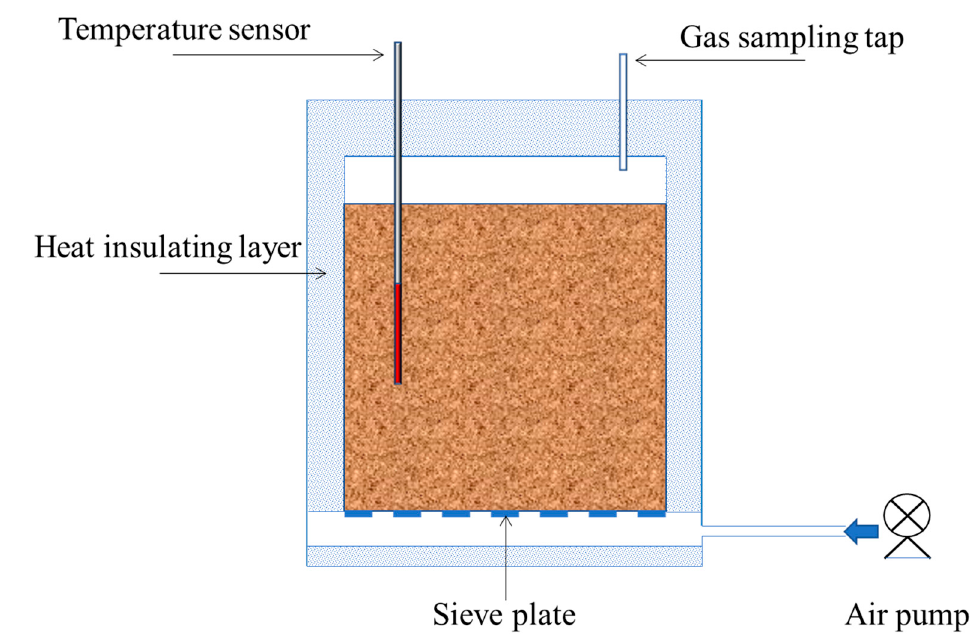
Figure 1. Schematic diagram of composting device.